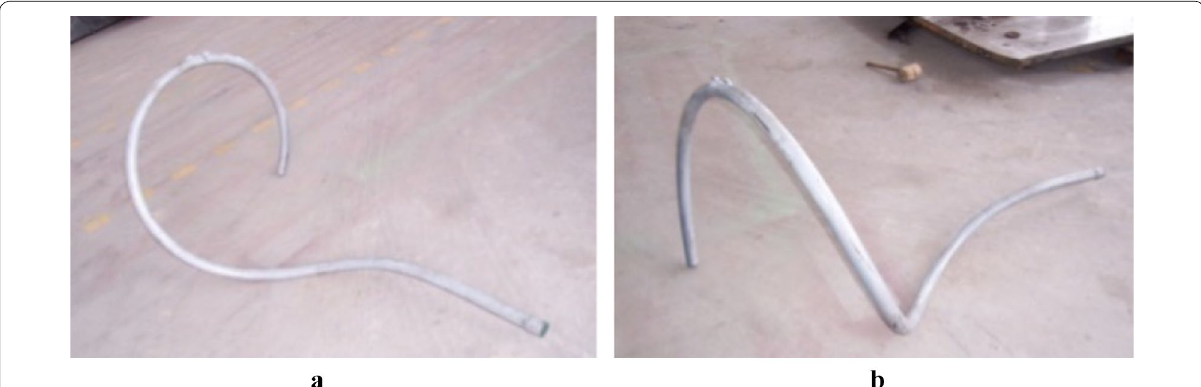
Figure 5 Laying head pipe before assemble: a laying head pipe from entrance side; b laying head pipe from exit